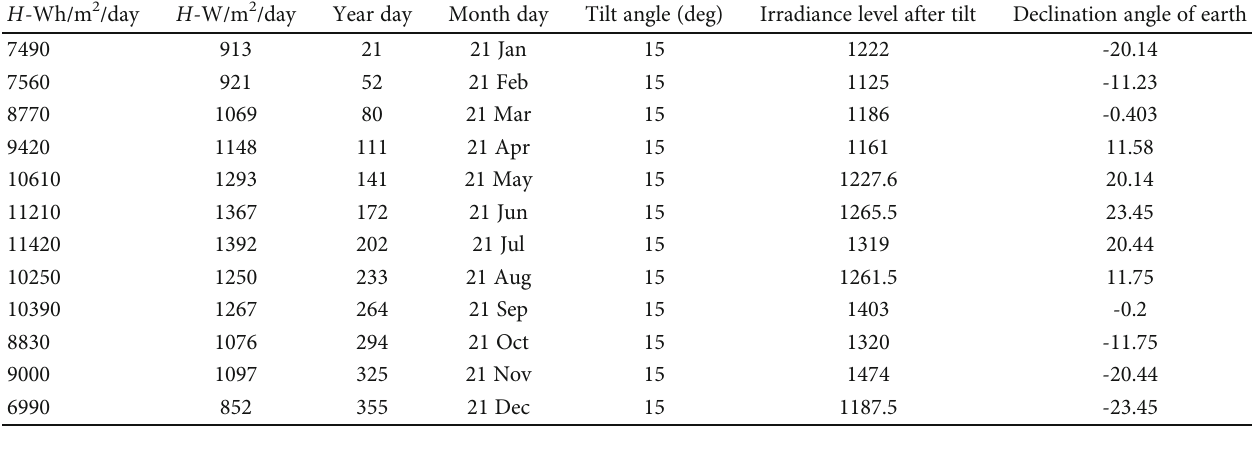
Table 1: Monthly speci fi c daily global irradiance ( H ), year days, days of the month, tilt angle (deg), irradiance level after tilt, and declination angle of the earth.